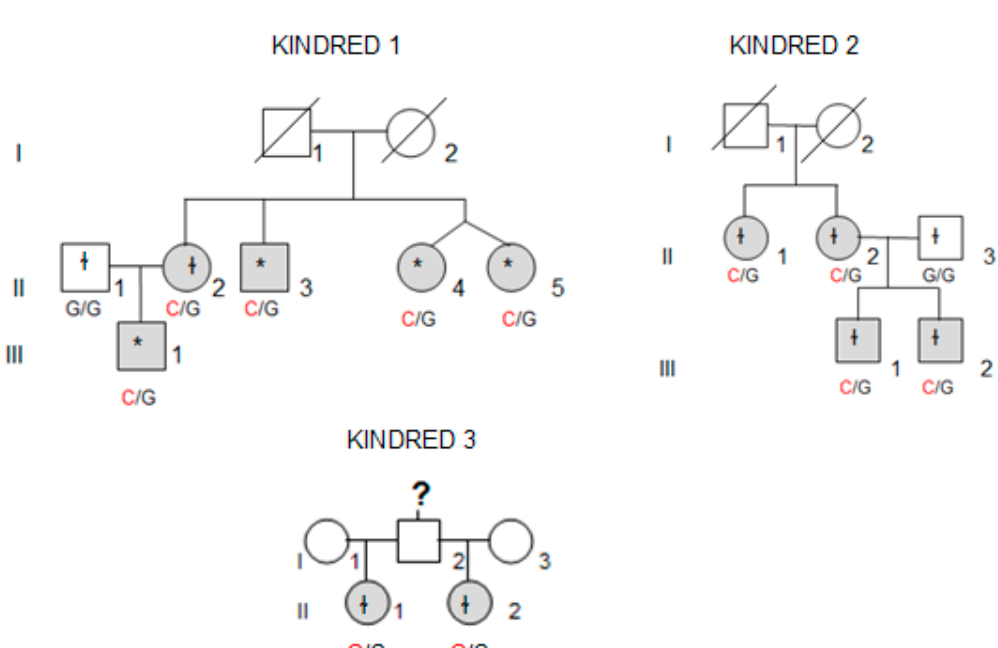
Figure 1. Family pedigrees for Kindreds 1, 2 and 3 and the NOP53 genotype for each heterozygous mutation (c.91G > C, p. Asp31His). Patients affected by thyroid cancer are shown in grey. The asterisk indicates p. Asp31His variant was observed in whole-exome sequencing (WES) and validated by Sanger sequencing, whereas ɬ indicates that the variant was identified using direct Sanger sequencing.